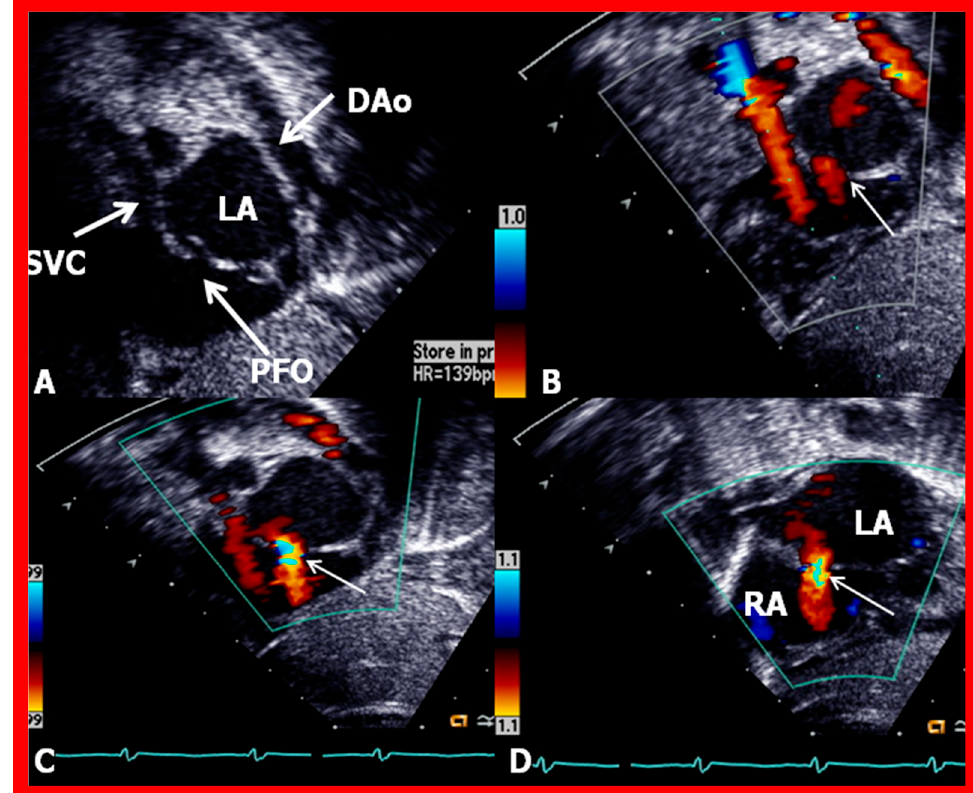
Figure 10. 2D ( A ) and color flow ( B – D ) images from subcostal short-axis views of the atrial septum, illustrating a patent foramen ovale (PFO) (arrow in ( A )) with a left-to-right shunt (thin arrows in ( B – D )). Note the overlapping of the septum primum over the septum secundum in ( A ), suggesting that this atrial defect is a PFO. DAo, descending aorta; LA, left atrium; RA, right atrium; SVC, superior vena cava. Reproduced from Reference [6].